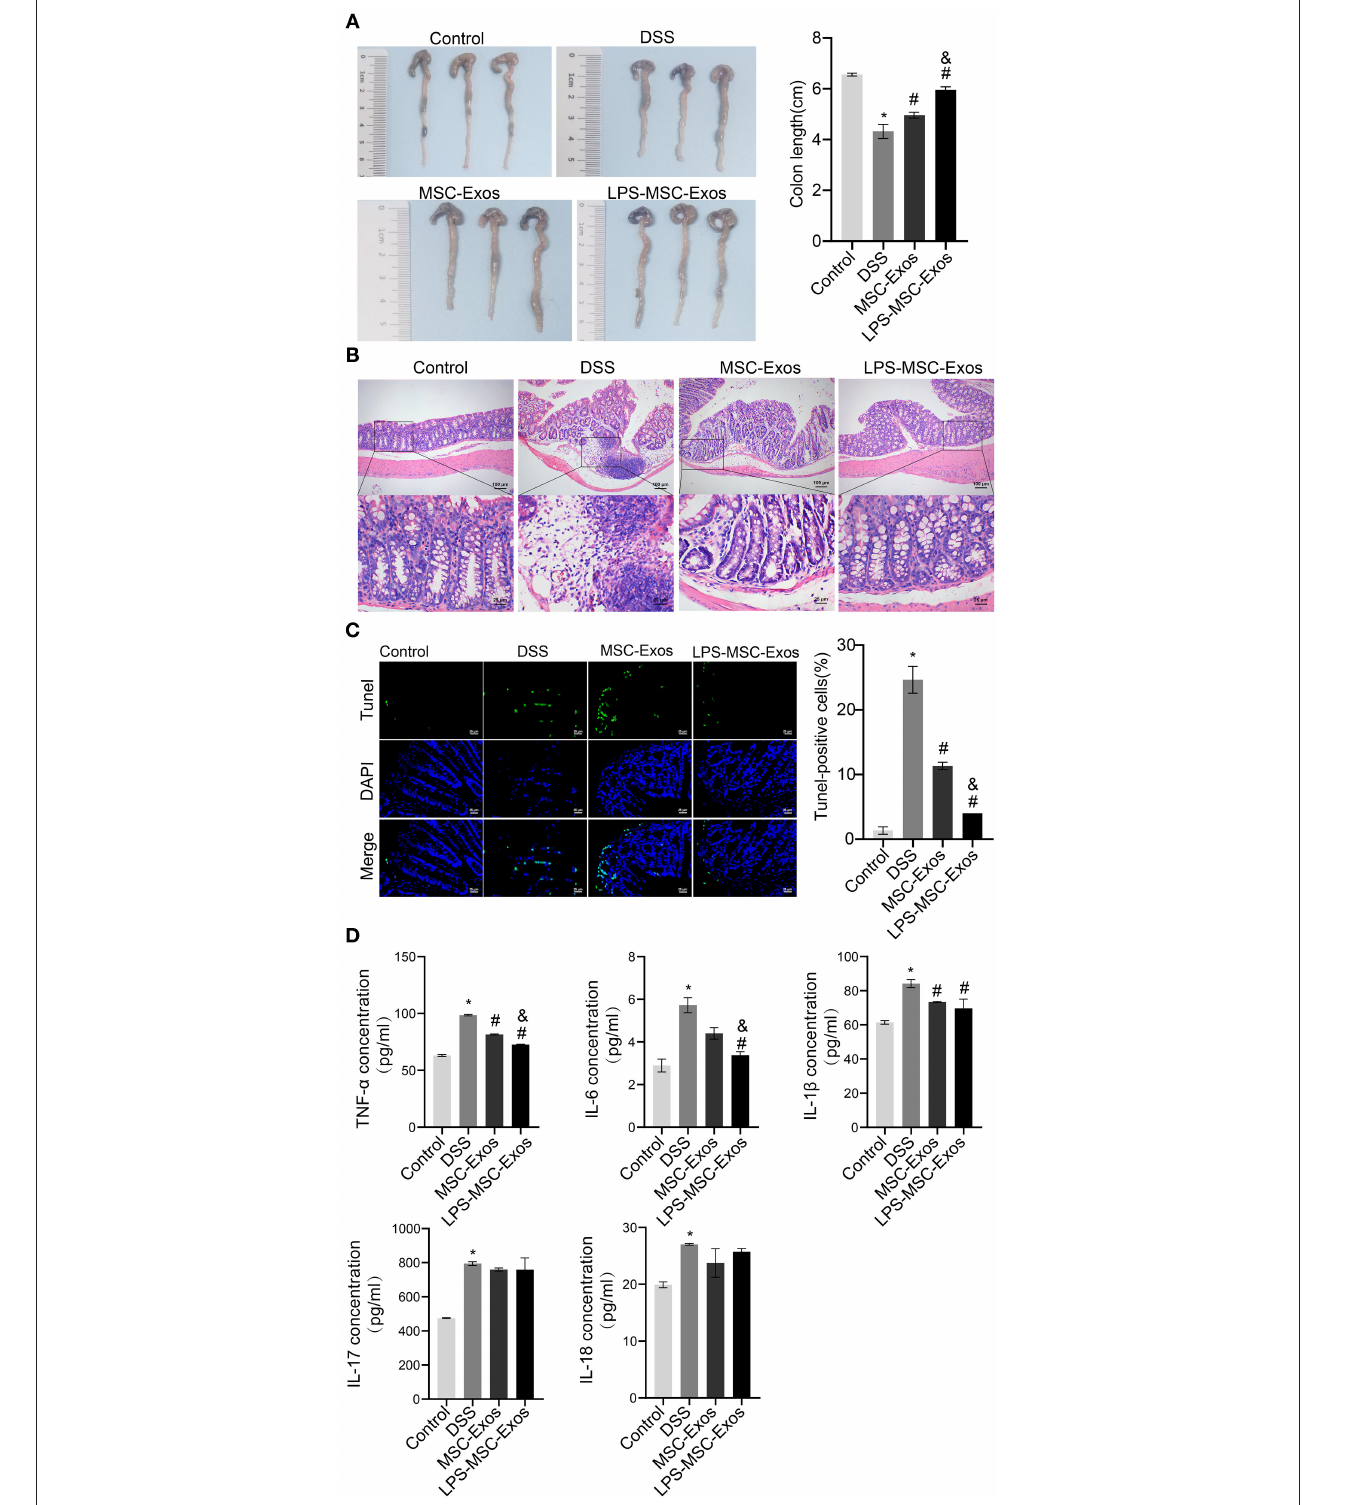
FIGURE 1 | MSC-Exos and LPS-MSC-Exos alleviated DSS-induced colitis in vivo . (A) The appearance and length of the colon in mice were analyzed. (B) H&E staining of colonic pathological features in the mice. Scale bar: 100 or 25 µ m. (C) A TUNEL assay was used to detect cell apoptosis in colonic tissue from the mice. Scale bar: 25 µ m. (D) The concentrations of TNF- α , IL-6, IL-1 β , IL-17, and IL-18 were measured via ELISA. * P < 0.05 vs. the control group. # P < 0.05 vs. the DSS group. & P < 0.05 vs. the MSC-Exo group. n = 10 mice/group. MSC, mesenchymal stem cell; Exos, exosomes; LPS, lipopolysaccharide; DSS, dextran sodium sulfate.